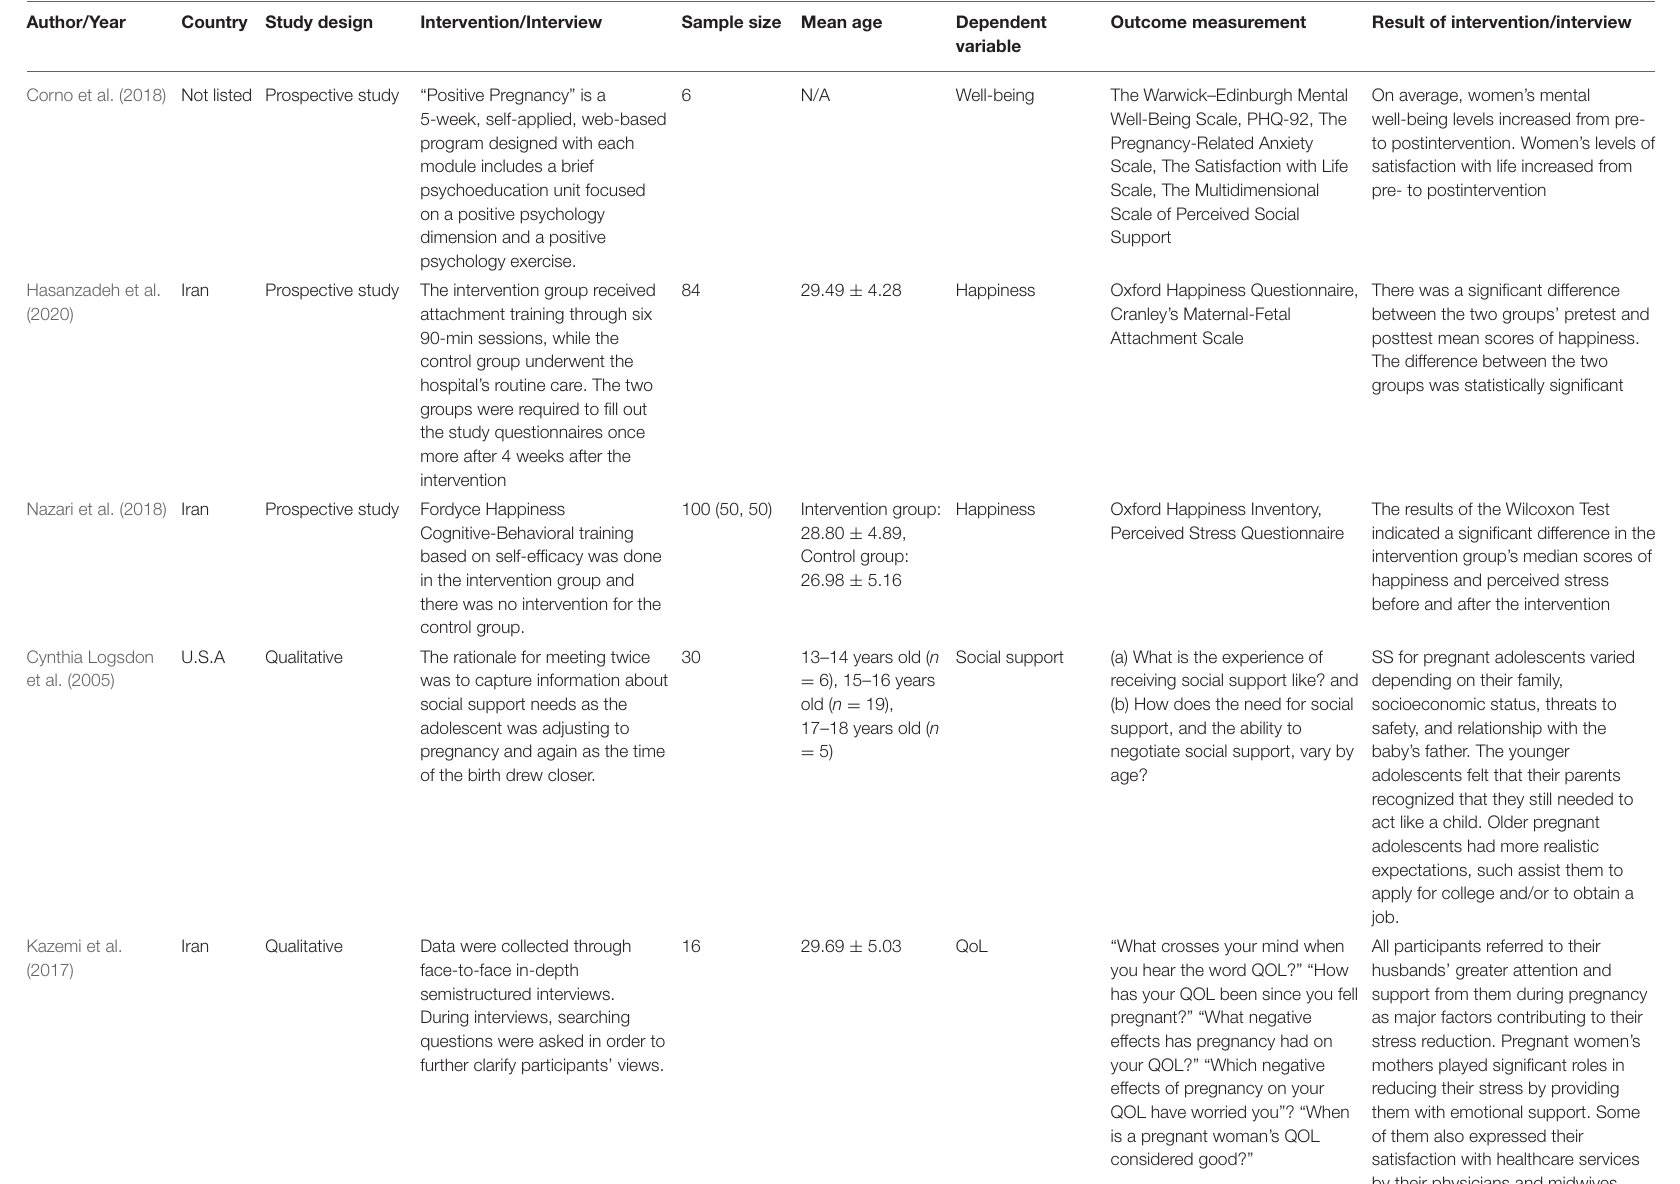
TABLE 5 | The intervention and qualitative assessments of SS, SWB among pregnant